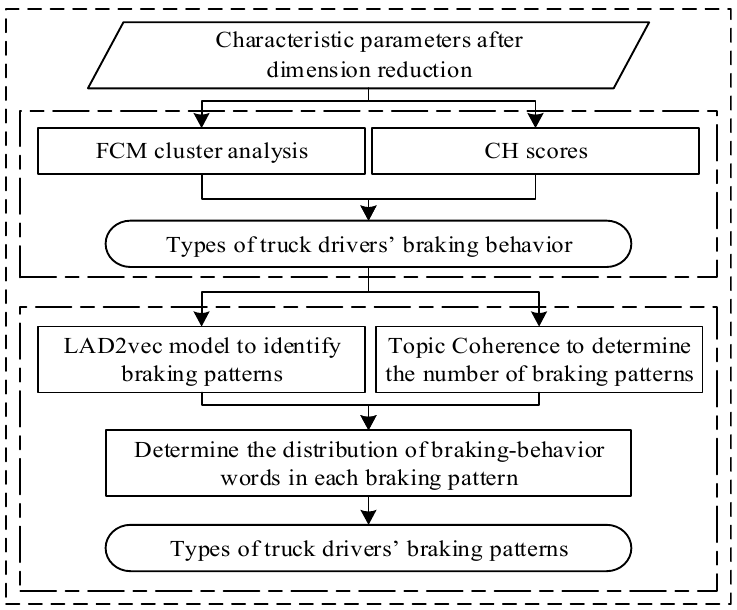
Figure 1. Framework of the truck drivers’ braking pattern recognition model.